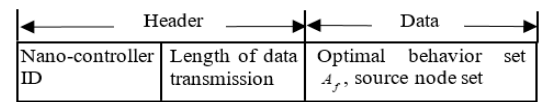
Figure 2. Time Slot Scheduling Packet Structure of CEH-TDMA.